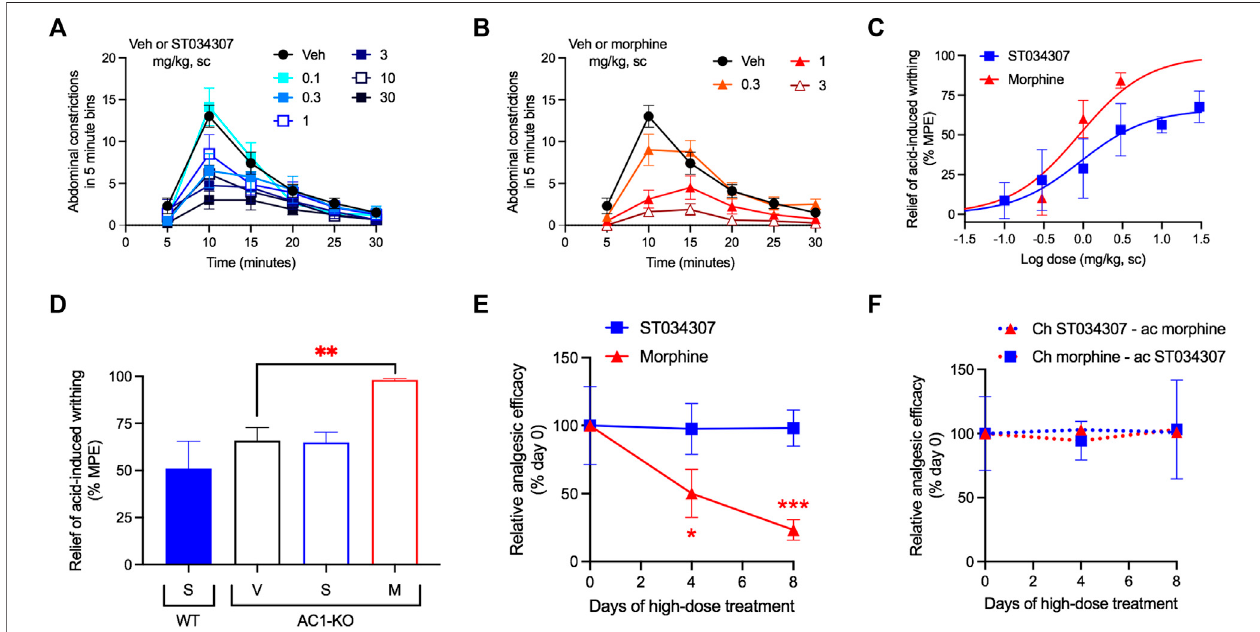
FIGURE 2 | ST034307 relieves visceral pain in mice. (A) Different doses of ST034307 reduce the number of abdominal constrictions caused by an intraperitoneal injection with 0.75% acetic acid; N = 8 – 10. (B) Different doses of morphine reduce the number of abdominal constrictions caused by an intraperitoneal injection with 0.75%aceticacid;N=8 – 10. (C) Dose-responsecurvesofthetotalnumberofabdominalconstrictionsfromthegraphsin (A) and (B) .Vehicle ’ sresponsewassetas0% andthemaximalpossibleeffect(0)to100%. (D) Reductionofthetotalnumberofabdominalconstrictionsinwild-type(WT)andinAC1-KOmicetreatedwithvehicle (V), 30 mg/kg ST034307 (S), or 10 mg/kg morphine (M). Vehicle ’ s response in wild-type mice was set as 0% and zero to 100%; N = 5. (E) Mice were injected daily with 30 mg/kgST034307or100 mg/kg morphine and on day fouror eight acid-induced writhing assayswere performed. Mice that chronically receivedmorphinedisplayed a decrease in ef fi cacy of 3 mg/kg morphine on days four or eight, compared to a group of mice that received vehicle plus 3 mg/kg morphine on day zero. Mice that chronically received ST034307 did not display any changes in ef fi cacy of 10 mg/kg ST034307; N = 5. (F) Mice were injected daily with 30 mg/kg ST034307 or 100 mg/kg morphine and on day four or eight acid-induced writhing assays were performed. Mice that chronically received morphine did not display any changes in ef fi cacy with 10 mg/kg ST034307. Mice that chronically received ST034307 did not display any changes in ef fi cacy with 3 mg/kg morphine; N = 5. Data in all graphs represent the average ±S.E.M. * p < 0.05, ** p < 0.01, *** p < 0.001 in one-way ANOVA with Dunnett ’ s